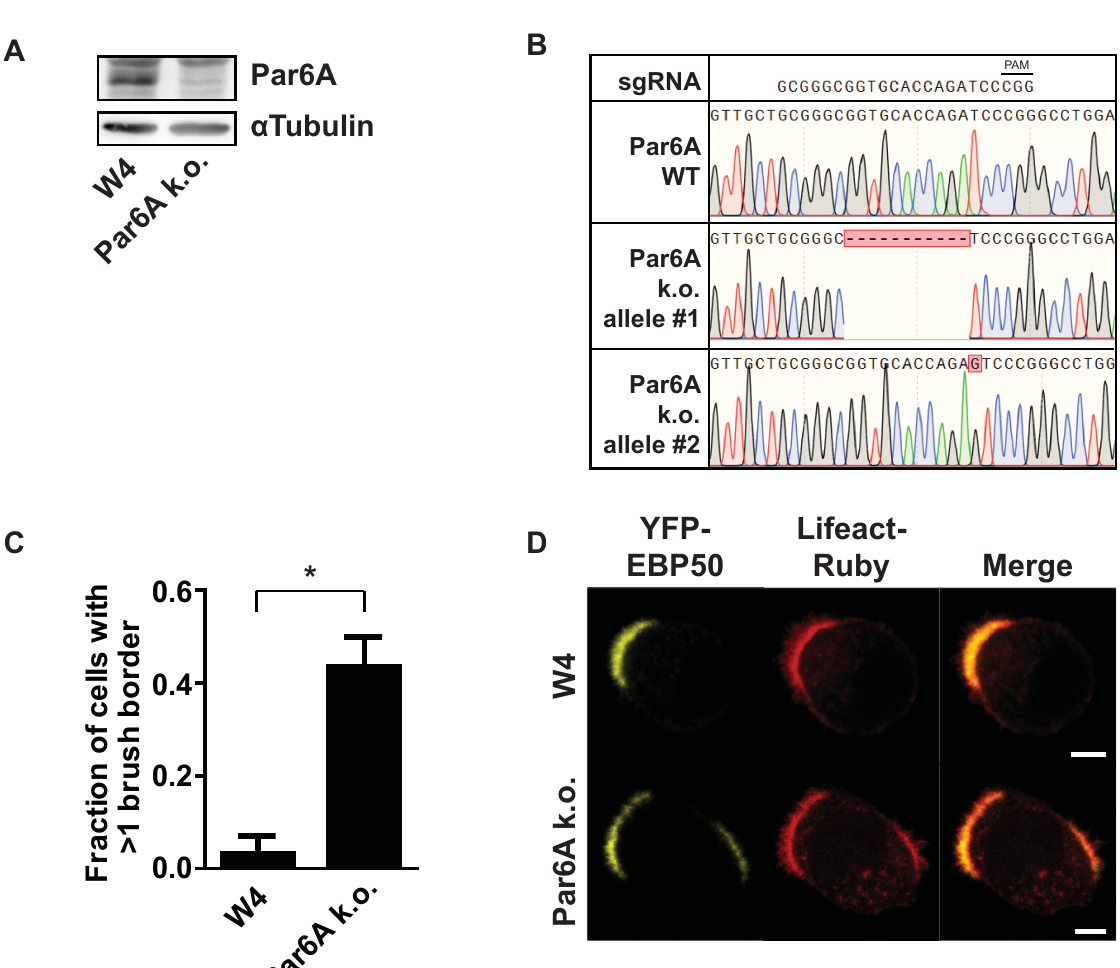
Fig 1. Par6A k.o. Ls174T:W4 cells form multiple brush borders upon polarization. A) Western blot of Ls174T:W4 and Par6A k.o. cell lysate probed with Par6A and α Tubulin antibody. B) Alignment of sequence traces of wild type Par6A and the two edited alleles of Par6A k. o. cells. The top row shows the short guide RNA (sgRNA) used for Cas9 mediated gene disruption and indicated in that sequence is the protospacer adjacent motif (PAM) sequence. C) Quantification of the fraction of cells that form more than one brush border as determined by YFP-EBP50 and lifeact-ruby distribution in polarized Ls174T:W4 or Par6A k.o. cells. Error bars indicate sd (n = 3, > 75 per experiment) � p < 0.05 using independent samples t-test. D) Representative images of polarized Ls174T:W4 and Par6A k.o. cells expressing YFP-EBP50 and lifeact-ruby. Scale bars indicate 5 μ